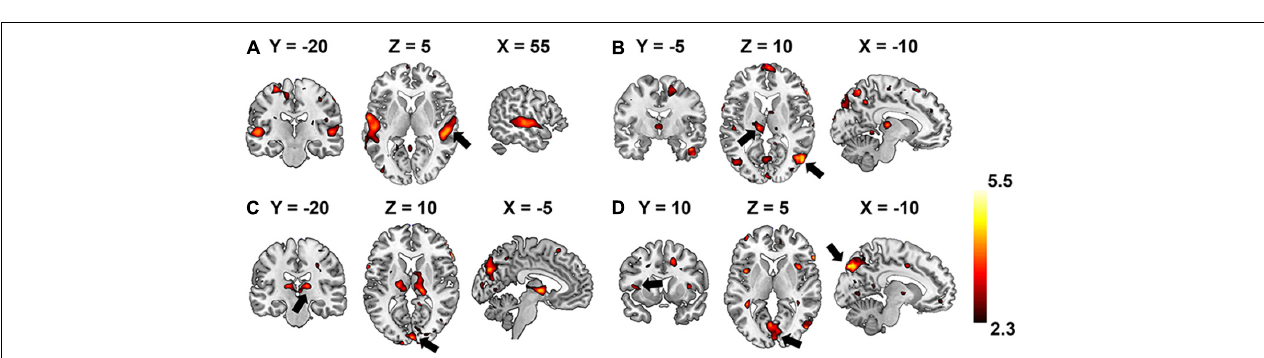
FIGURE 7 | The comparison of encoding performance between the unsupervised DCAE model and supervised classification model in each layer. A1, primary auditory cortex; aSTG, anterior superior temporal gyrus; pSTG, posterior superior temporal gyrus; MTG, middle temporal gyrus; VC, visual cortex; PFC, prefrontal cortex.